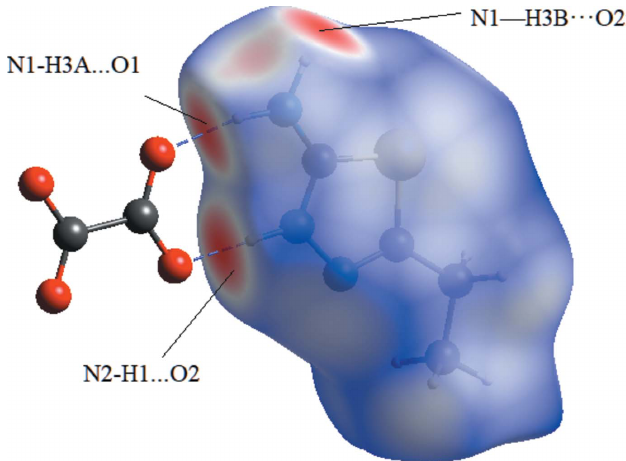
Figure 6 The Hirshfeld surface mapped over d norm for compound (I) indicates that the most important contributions to the crystal packing are from O (cid:2)(cid:2)(cid:2) H/ H (cid:2)(cid:2)(cid:2) O (39.1%) and H (cid:2)(cid:2)(cid:2) H (29.0%)